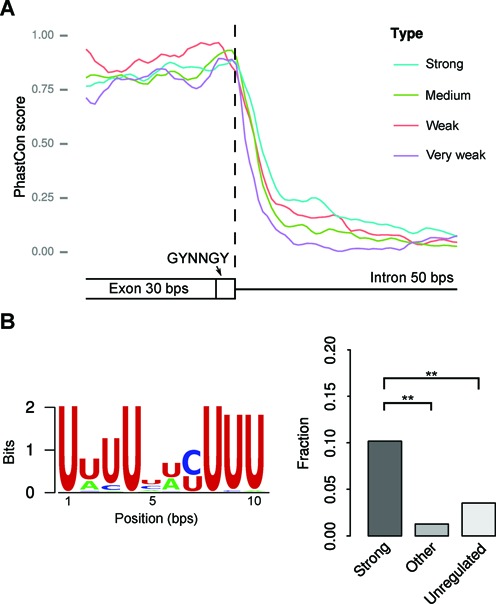
(A) Strongly regulated AS GYNNGYs have more conserved downstream flanking intronic sequence than other AS GYNNGYs (paired Wilcoxon rank sum test, P < 1 x 10-6). The vertical dash line indicates the end of GYNNGY. (B) The U-rich motif is enriched in strongly regulated AS GYNNGYs (**P < 0.01). ‘Strong’, ‘Medium’, ‘Weak’ and ‘Very weak’ denote GYNNGY groups with different degrees of regulation (measured by ΔUMS). ‘Other’ consists of ‘Medium’, ‘Weak’ and ‘Very weak’ groups. ‘Unregulated’ represent unregulated AS GYNNGYs.